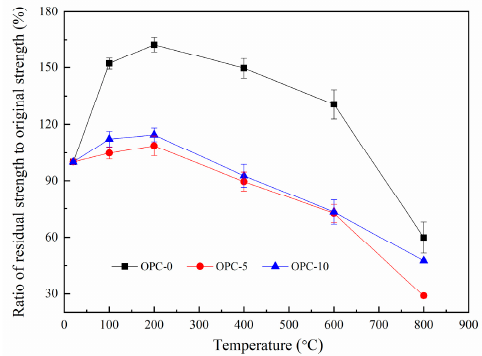
Figure 8. Ratio of residual compressive strength to original compressive strength.